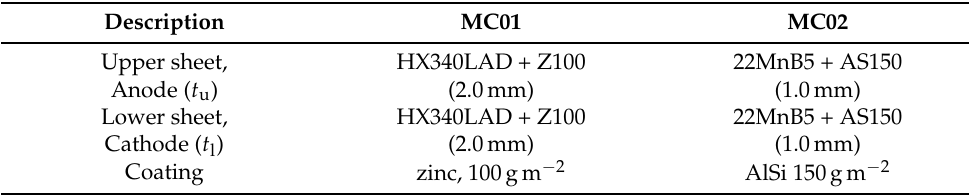
Table 1. Material combinations (MC) for experimental investigations.